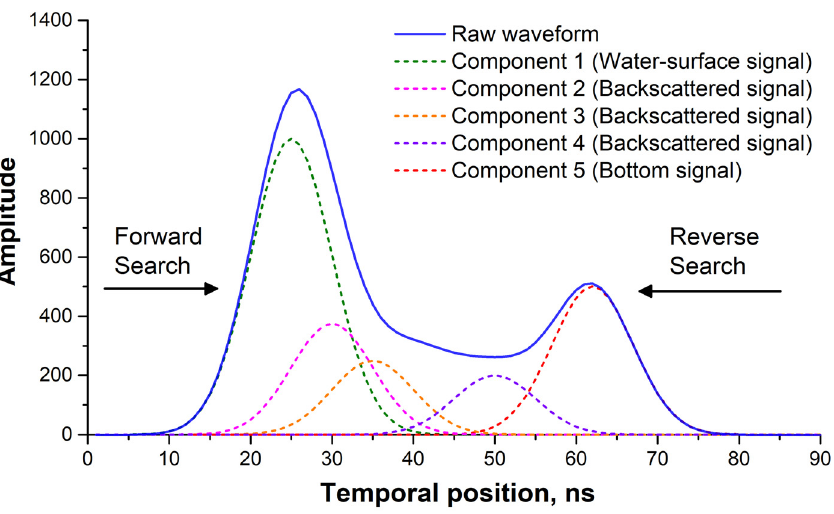
Figure 6. Waveform decomposition and detection of surface- and bottom-water waveform compo- nents.